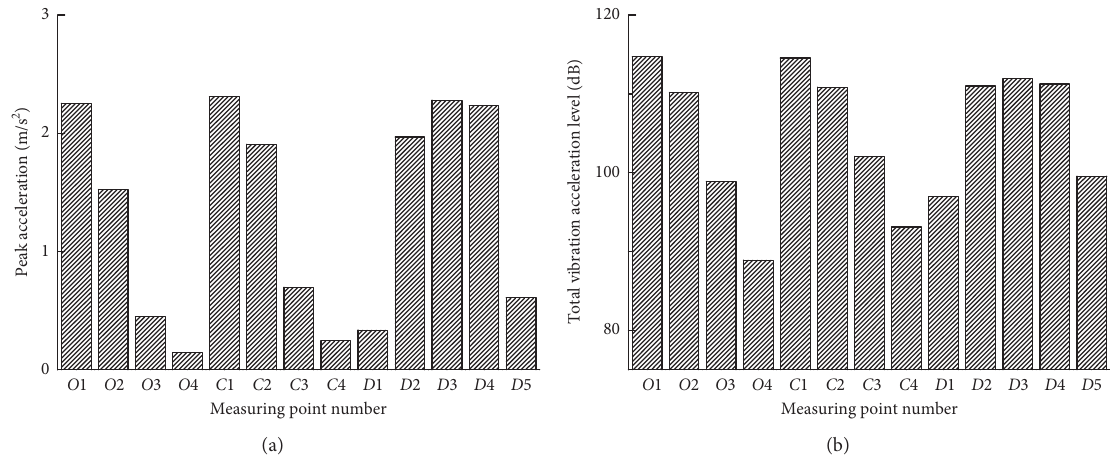
Figure 17: Vibration of SESB: (a) peak acceleration on the steel frame; (b) overall vibration acceleration level on the steel